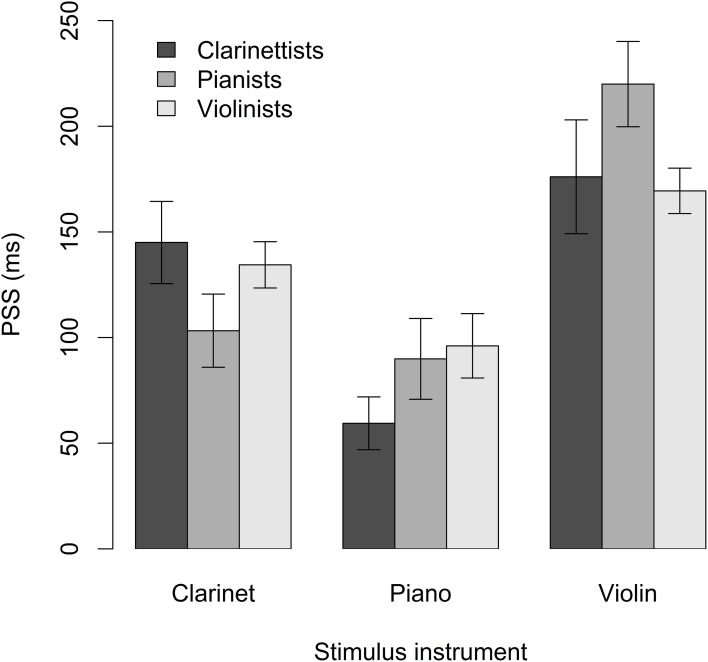
Mean PSS across stimulus instruments and expertise groups. Error bars indicate standard error. At positive PSS values, audio lagged behind video.